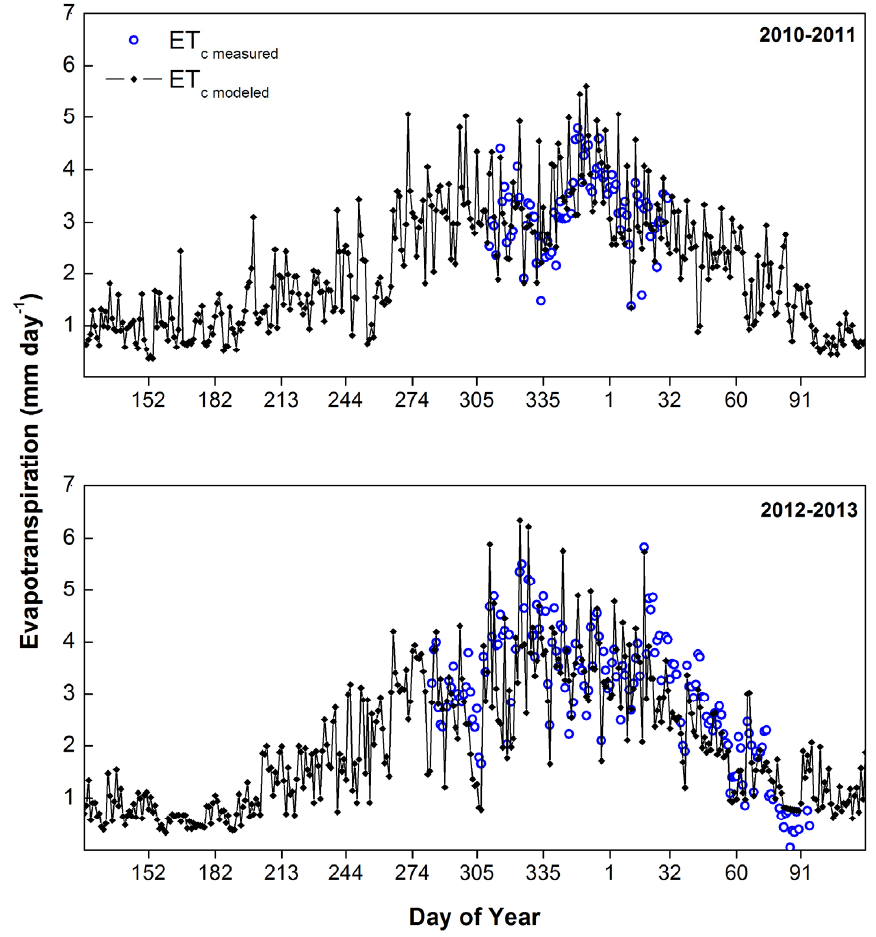
Figure 4. Temporal evolution of measured and modeled evapotranspiration for the drip-irrigated apple orchard (ET c ) during the 2010–11 and 2012–13 seasons.